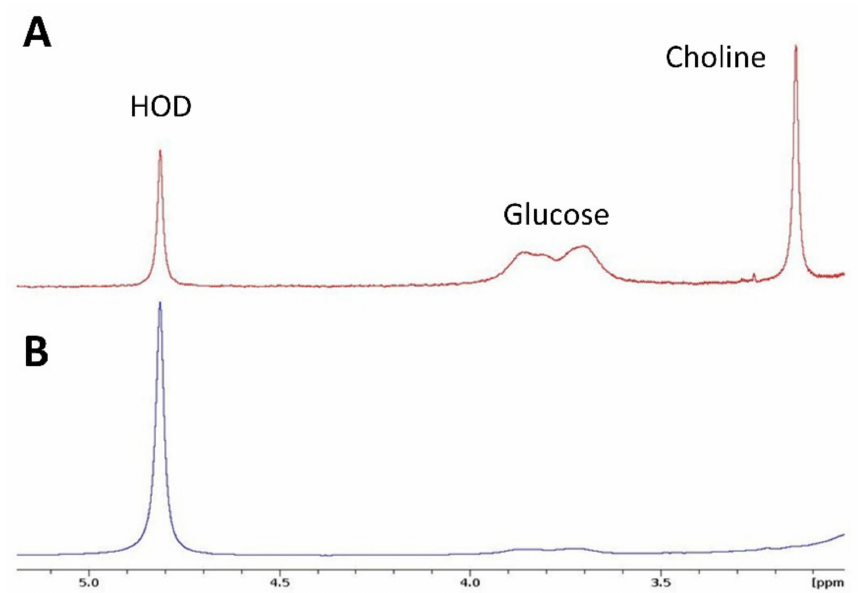
Figure 4. 2 H MR spectra recorded from plasma samples after infusion of a mixture of [6,6 (cid:48) - 2 H 2 H 2 ]glucose and [ 9 ]choline in mice carrying a subcutaneous renal tumor. ( A ). Spectrum taken immediately after infusion. ( B ). Spectrum taken 15 min after infusion. The 2 H signal for glucose is strongly reduced and that for choline signal is absent. Vertical scales are